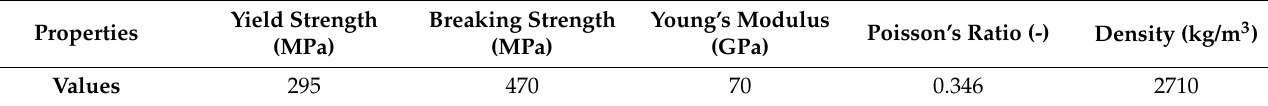
Table 2. Mechanical properties of aluminum EN